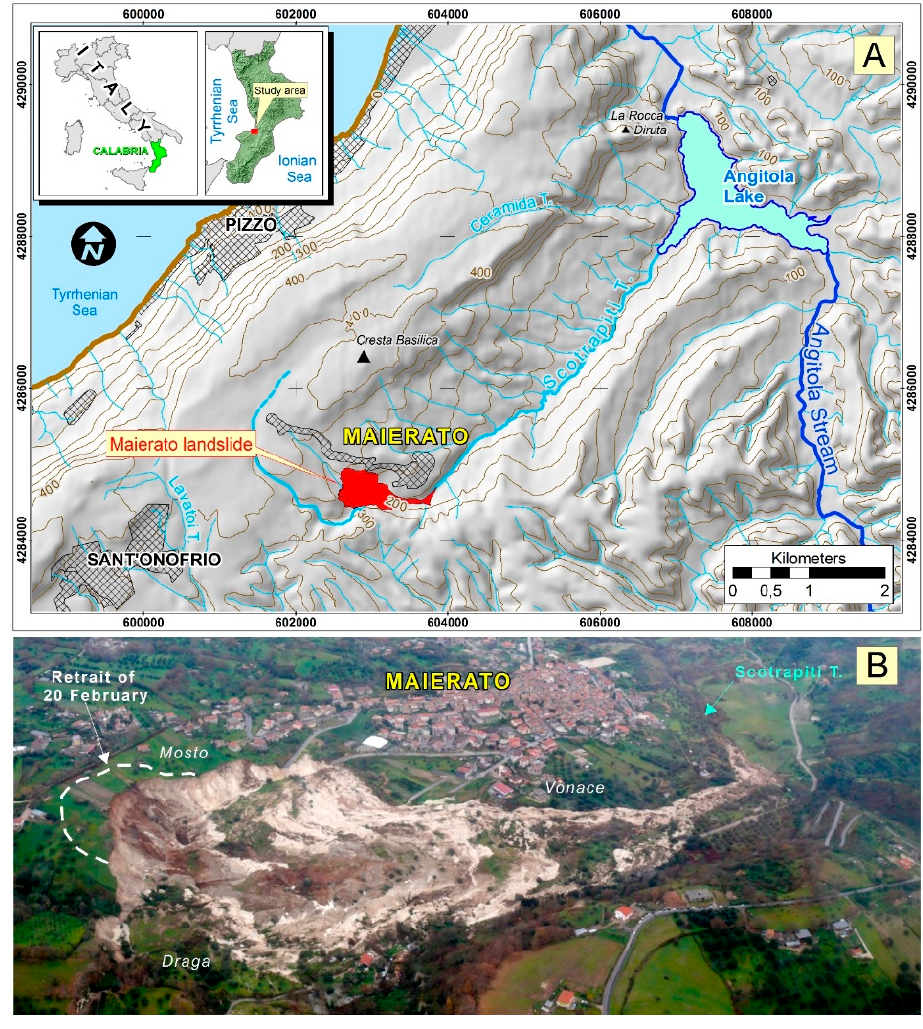
Figure 1. Location ( A ) and panoramic view ( B ) of Maierato landslide occurred on 15 February 2010 (helicopter photo taken on 16 February 2010, by G.G.).